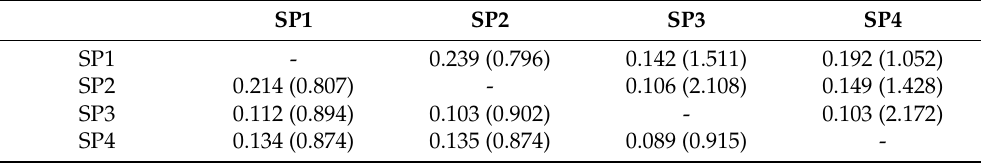
Table 4. Pairwise estimates of gene flow (above diagonal, within the brackets), genetic differentiation (FST) (above diagonal off brackets), genetic distance (GD) (lower diagonal off brackets), and genetic identity (GI) (lower diagonal within the